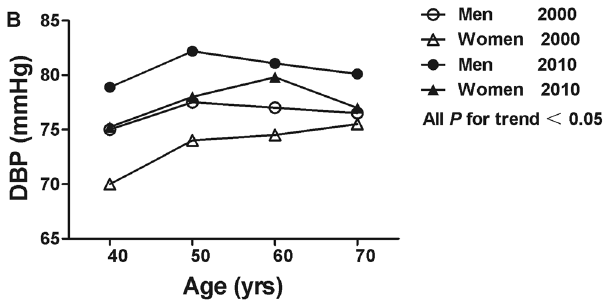
Figure 2. Mean diastolic blood pressure (DBP) across age groups by sex in 2000 and